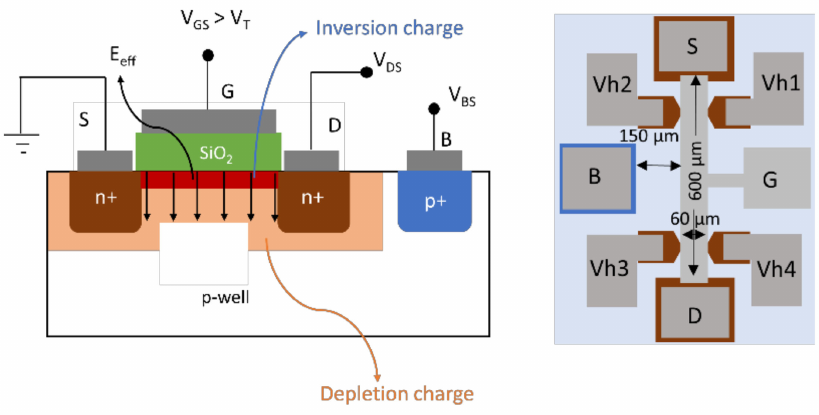
Figure 1. ( left ) Schematic diagram of lateral n-channel Hall MOSFET with the transverse electric field E ef f shown, which depends on space charge and inversion charge in the channel at a gate voltage higher than the threshold voltage. ( right ) Top view of a schematic of the fabricated Hall bar MOSFET. Vh1, Vh2, Vh3, and Vh4 represent the Hall voltage